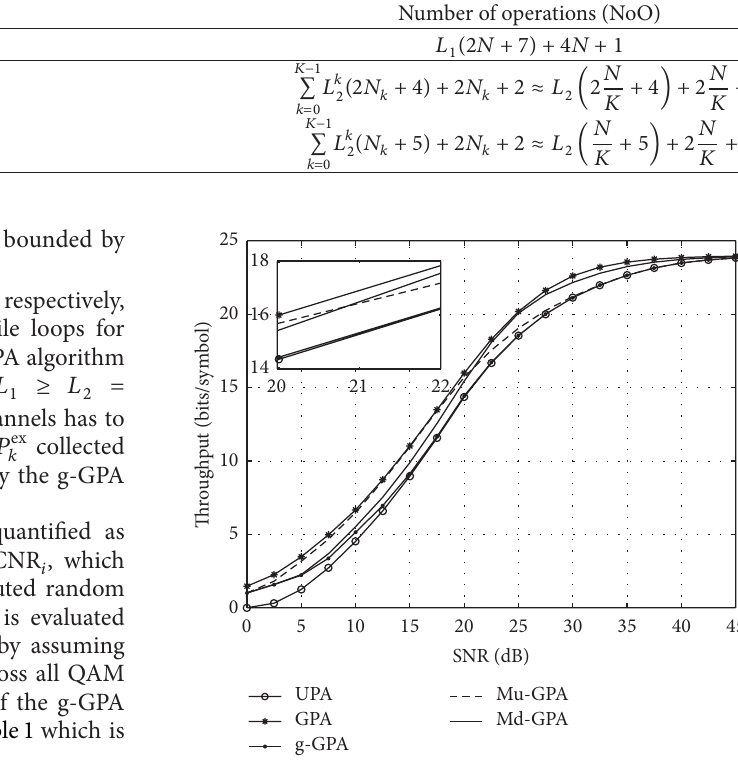
Figure 4: Overall throughput for a 4×4 MIMO system with a target BER of P target 𝑏 = 10 −3